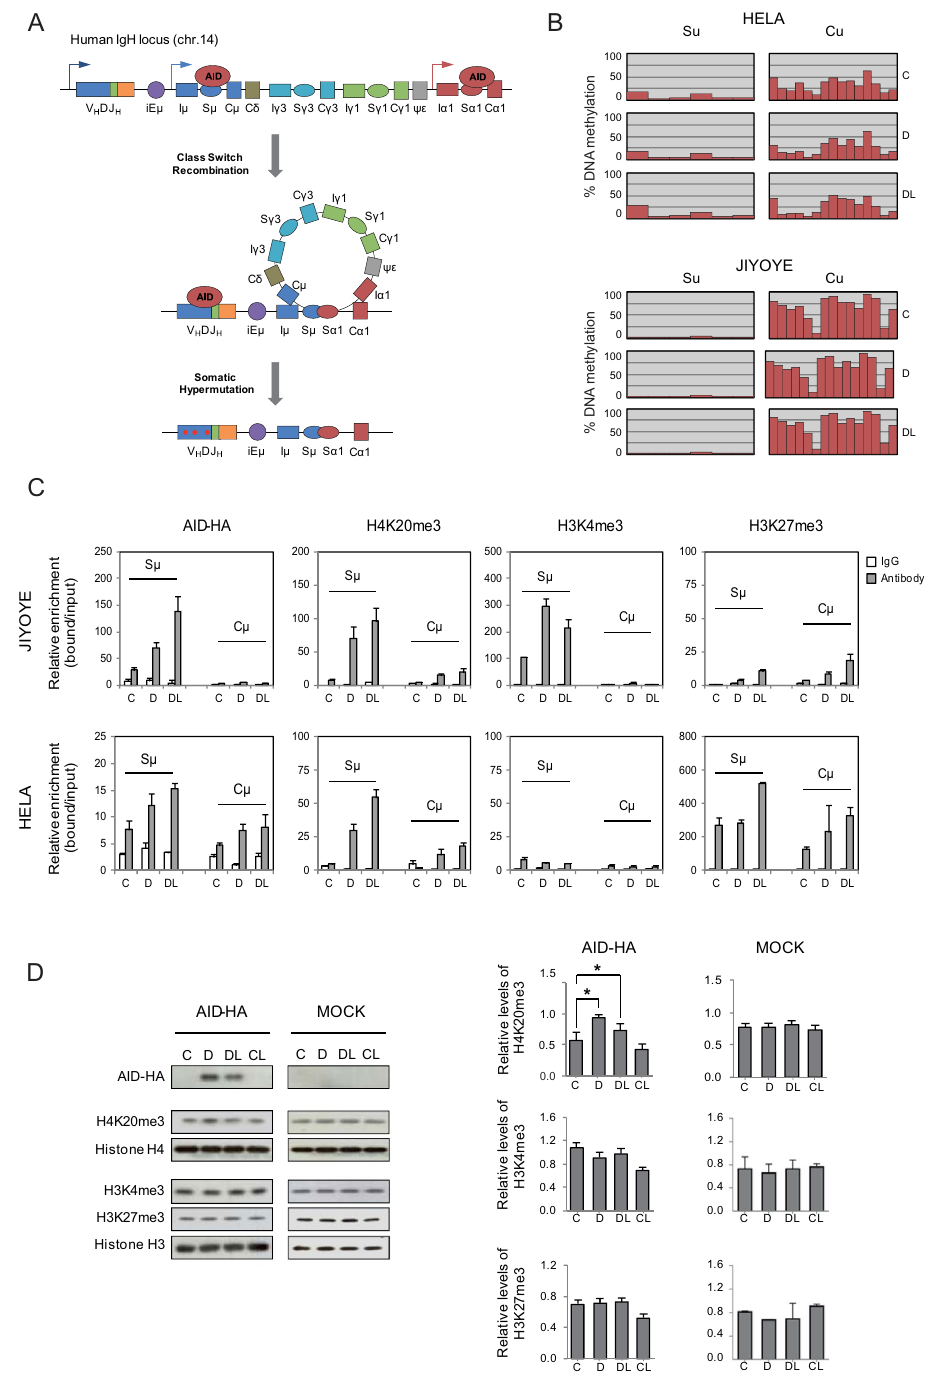
Figure 2. Effects of AID binding on the epigenetic status of the IGH locus. ( A ) Schematic representation of the IGH locus, and the participation of AID in class switch recombination and somatic hypermutation. S μ and C μ regions within this locus are bona fide binding and non-binding sites for AID and are used to test the effects of AID on epigenetic status. ( B ) Bisulphite pyrosequencing of the S μ and C μ regions in HeLa and Jiyoye cells transduced with the inducible retroviral system before (C) and after induction with doxycycline (D), and following inhibition of nuclear export with leptomycin B (DL). Each red bar shows the percentage of DNA methylation at a CpG site. 6 CpG sites were analysed at S μ region, whereas 15 CpG sites were analysed at C μ region (additional details in Supplementary Figure 1A). ( C ) AID association and selected histone modifications at the C μ and S μ regions using ChIP assays. AID was immunoprecipitated using anti-HA. ChIP assays also included H4K20me3, H3K27me3, H3Ac, H3K4me3 at the C μ and S μ regions. IgG was used as a negative control. For HeLa and Jiyoye cells we used control (C), doxycycline (D), and doxycycline + leptomycin B conditions (DL). Y-axis shows the relative enrichment of bound fraction with respect to input fraction. ( D